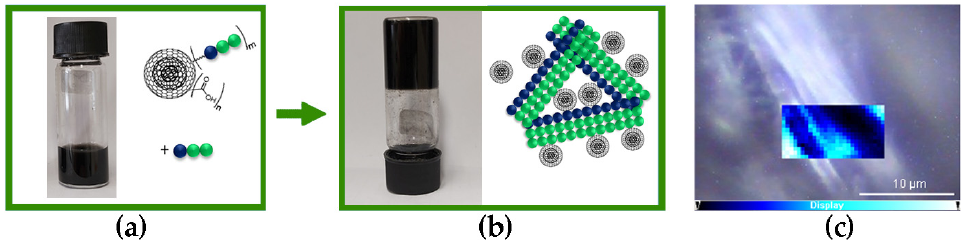
Figure 8. Photographs of: ( a ) Lff ‐ PEG ‐ CNOs (N ‐ terminus approach) with the self ‐ assembling tripeptide Lff in alkaline (pH 11.8) sodium ‐ phosphate precursor solution; ( b ) nanocomposite supramolecular hydrogels with Lff ‐ PEG ‐ CNOs (1.0 mg/mL) and 2.5 mg/mL of Lff at pH 7.4. ( c ) Raman mapping of a hydrogel fiber; intensity scalebar: brighter cyan areas correspond to higher levels of Lff ‐ PEG ‐ CNOs.